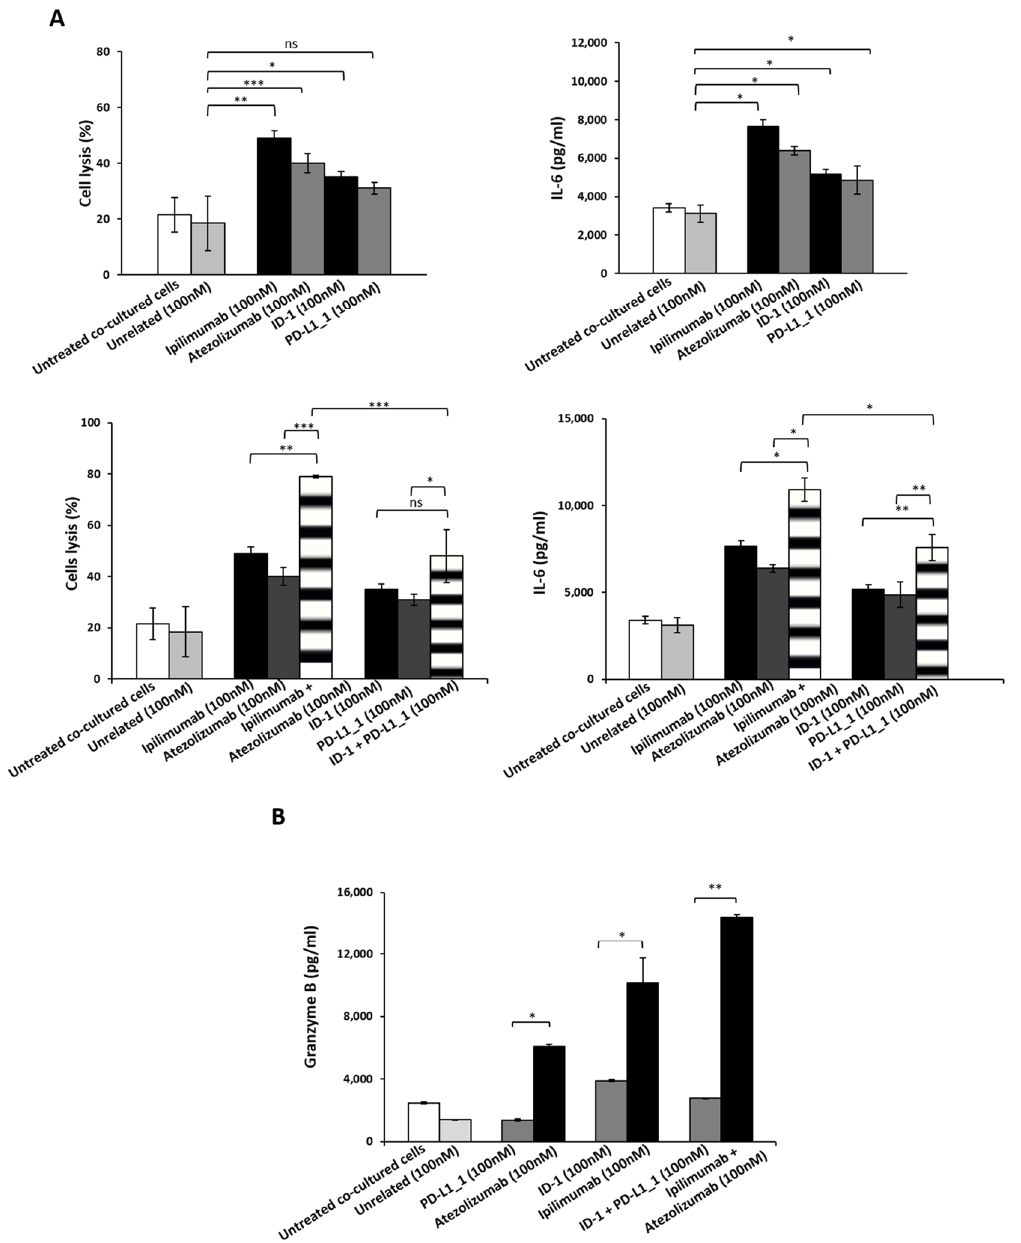
Figure 5. Cardiotoxic and pro-inflammatory effects induced by immunomodulatory mAbs or their combination on human fetal cardiomyocytes. ( A ) Cardiotoxicity of novel immunomodulatory mAbs was analyzed by detecting the LDH released by HFC cells co-cultured with hPBMCs in the absence or presence of single mAbs (black and grey bars) or their combinations (striped bars) for 24 h. The pro-inflammatory effects of the indicated immunomodulatory mAbs were analyzed by evaluating the secretion of IL-6 in the supernatant of the co-cultures treated with anti-CTLA-4 (black bars), anti-PD-L1 mAbs (dark grey), or their combination (striped bars). IL-6 is expressed as pg/mL. ( B ) The release of Granzyme B was evaluated by detecting its levels in the supernatant of co-cultures treated as indicated. As negative controls, cells untreated or treated with unrelated IgG were used (white and grey bars, respectively). The values were reported as the mean of at least three determinations obtained in three independent experiments. Error bars depict means ± SD. *** p ≤ 0,001; ** p < 0.01; * p < 0.05.